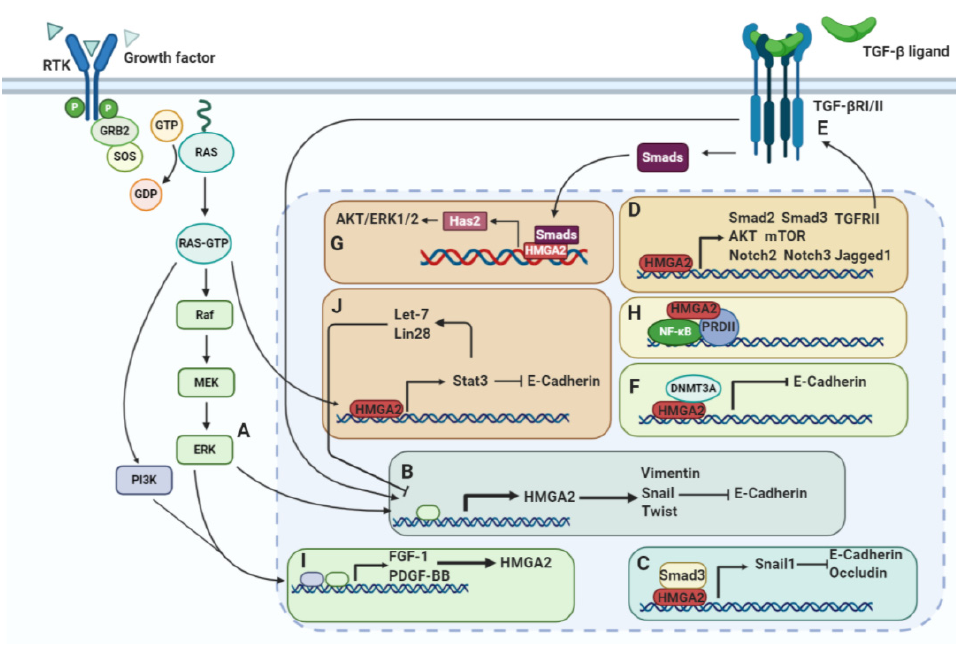
Figure 5. HMGA2 induces EMT by activation of different signaling transducers. ( A ) HMGA2 expression is induced by the RAF/MEK/ERK pathway. ( B ) HMGA2 promotes the expression of vimentin, Snail and Twist and reduces E-cadherin expression. ( C ) Colocalization of HMGA2 and smad3 on the Snail1 promotor induces expression of Snail1, and then Snail1 inhibits E-cadherin and occludin expression. ( D ) HMGA2 controls activation of the TGF β , MAPK, and Notch pathways by regulating the main elements, including Smad2, Smad3, TGF β RII, AKT, mTOR, Notch2, Notch3, and Jagged1. ( E ) TGF β RII induced by HMGA2 increases activity of the TGF β signaling pathway, which promotes HMGA2 expression in a positive feedback loop. ( F ) Long-term TGF β signaling activation causes HMGA2 to recruit DNMT3A to the E-cadherin gene promoter and inactivates its transcription by DNA methylation. ( G ) During TGF β pathway signaling, Smads cooperate with HMGA2 to bind to the Has2 promoter, inducing expression of Has2, which then activates AKT/ERK1/2 signaling. ( H ) HMGA2 enhances the binding of NF κ B to the positive regu- latory domain II (PRDII) transcription factor. ( I ) Regulators downstream of the MAPK and PI3K